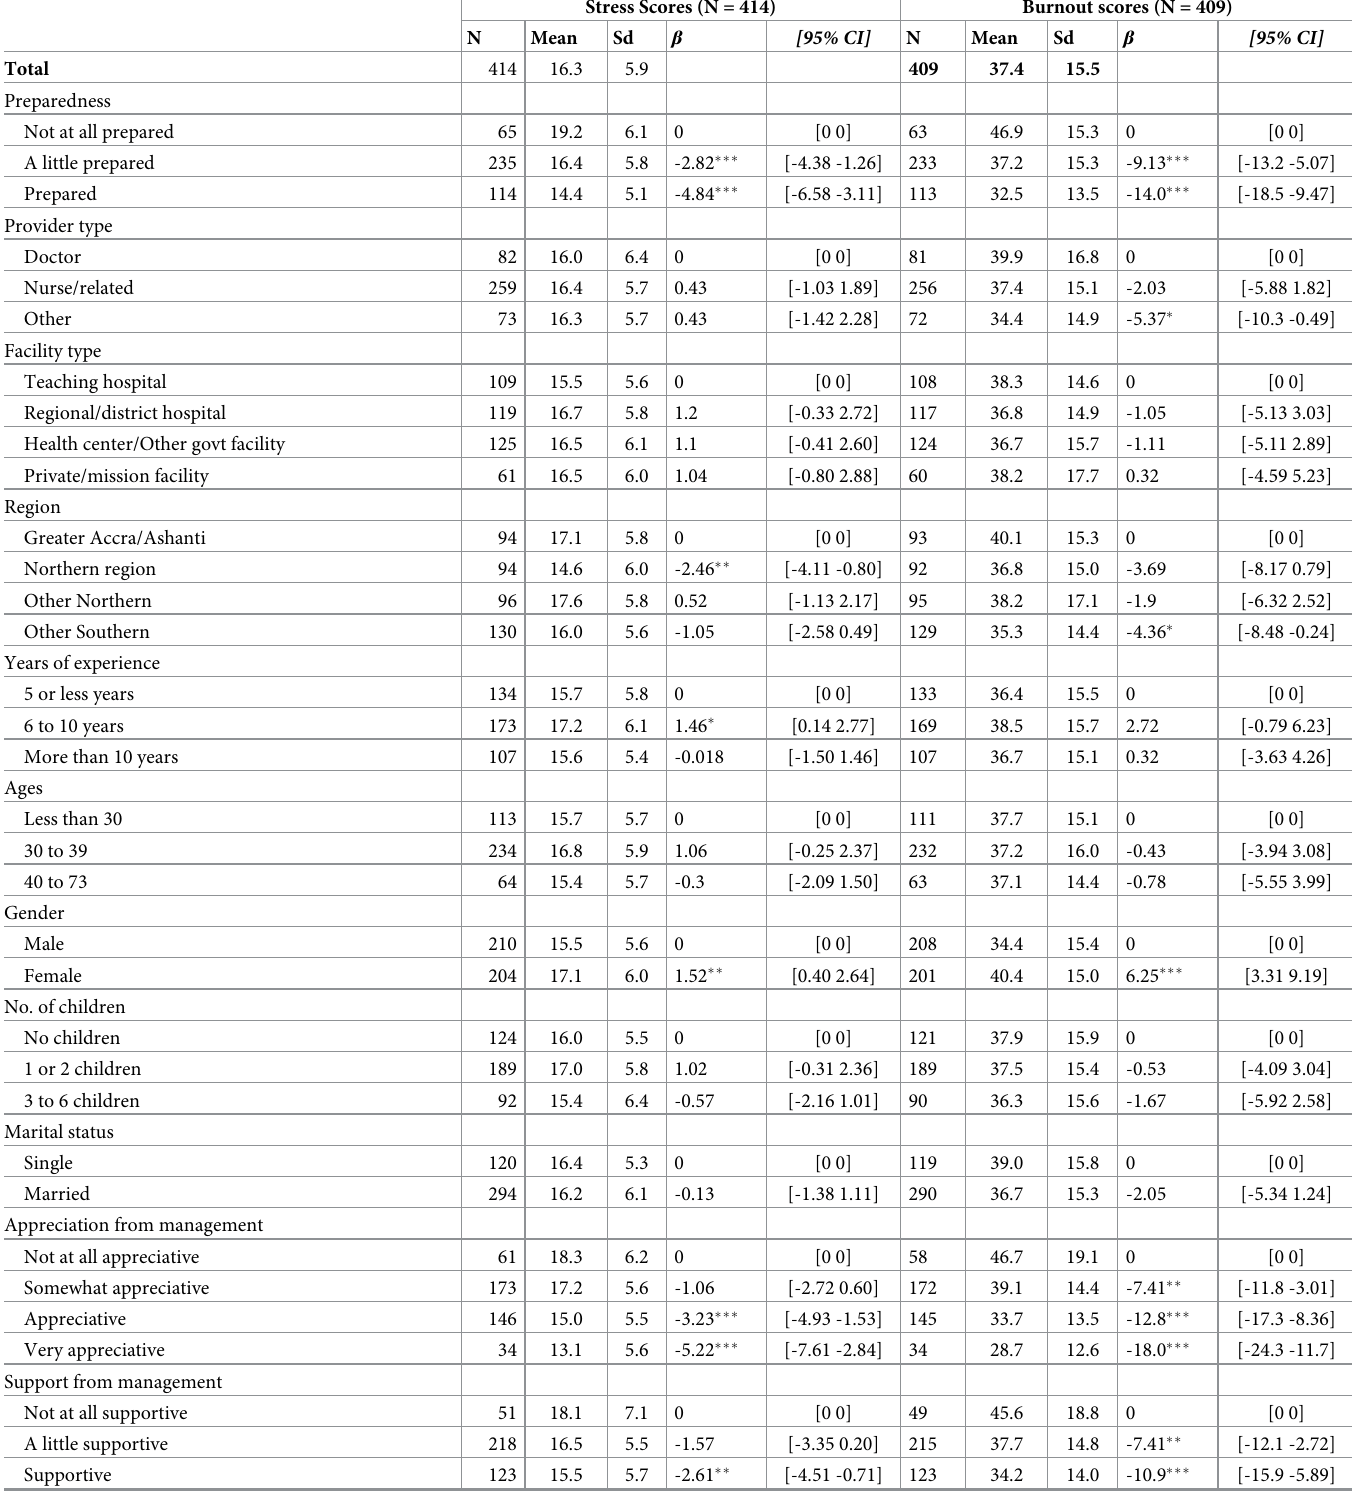
Stress Scores (N =